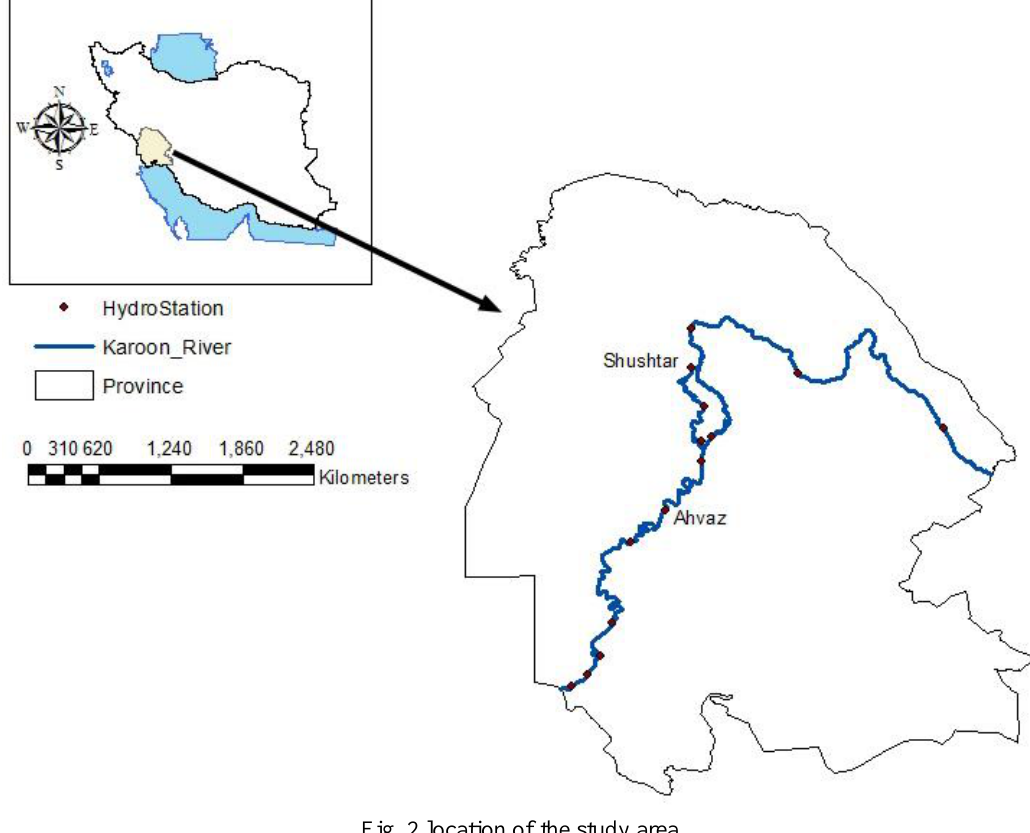
Fig. 2 location of the study